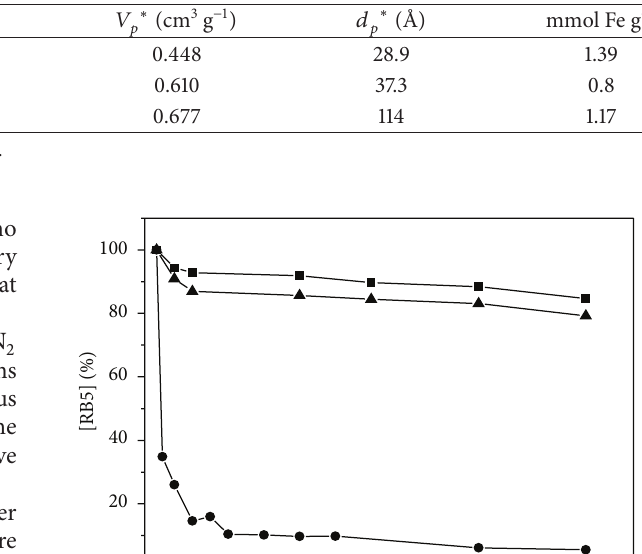
Table 1: Textural parameters of the different substrate used in RB5 decolourization.